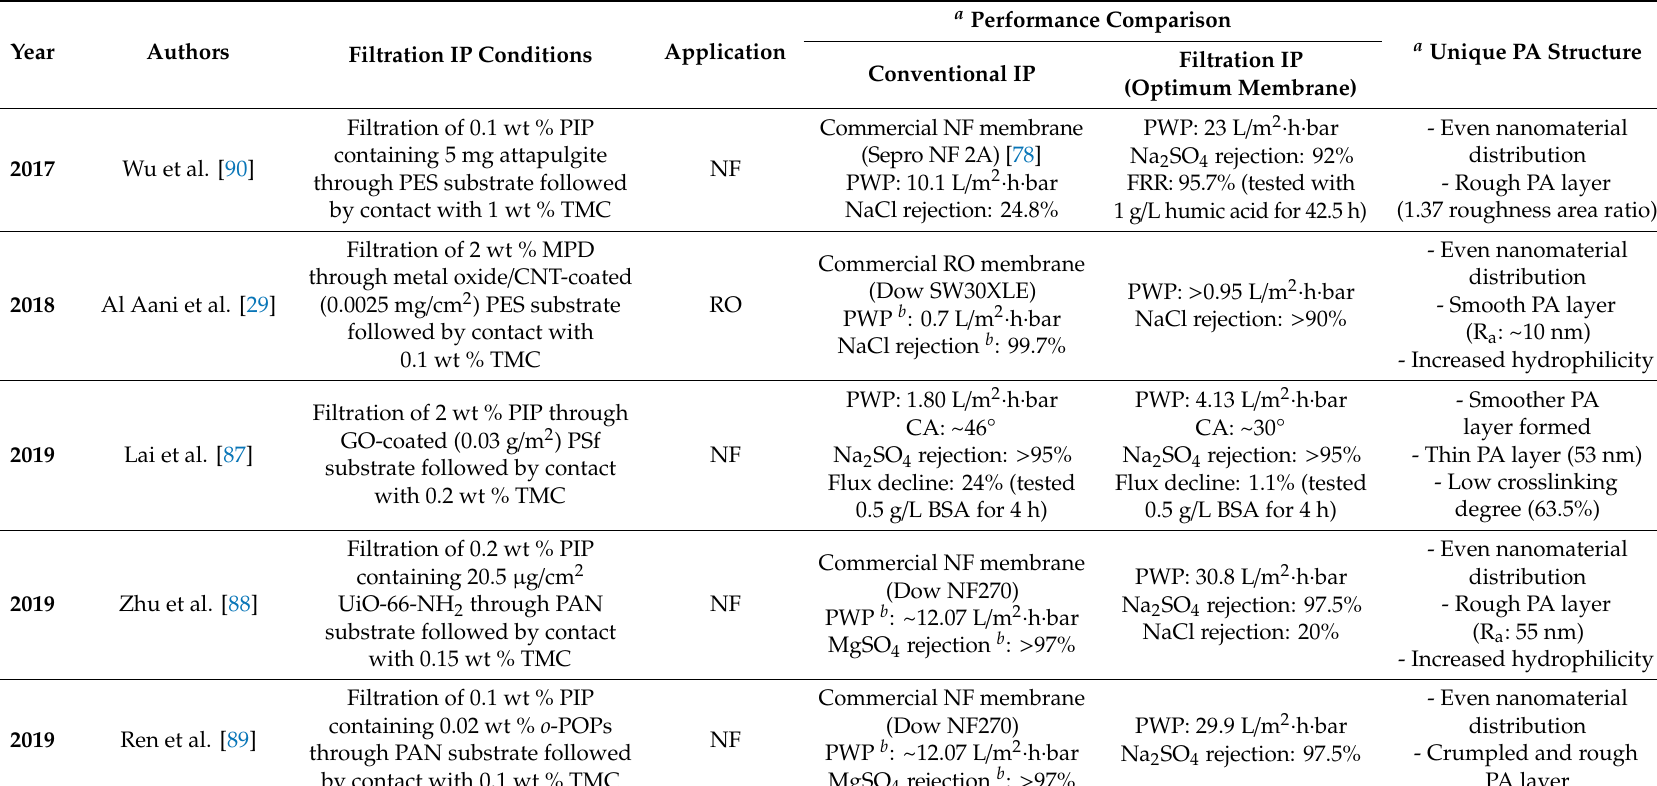
Table 2. Comparison of TFN membranes fabricated by using conventional and filtration-based